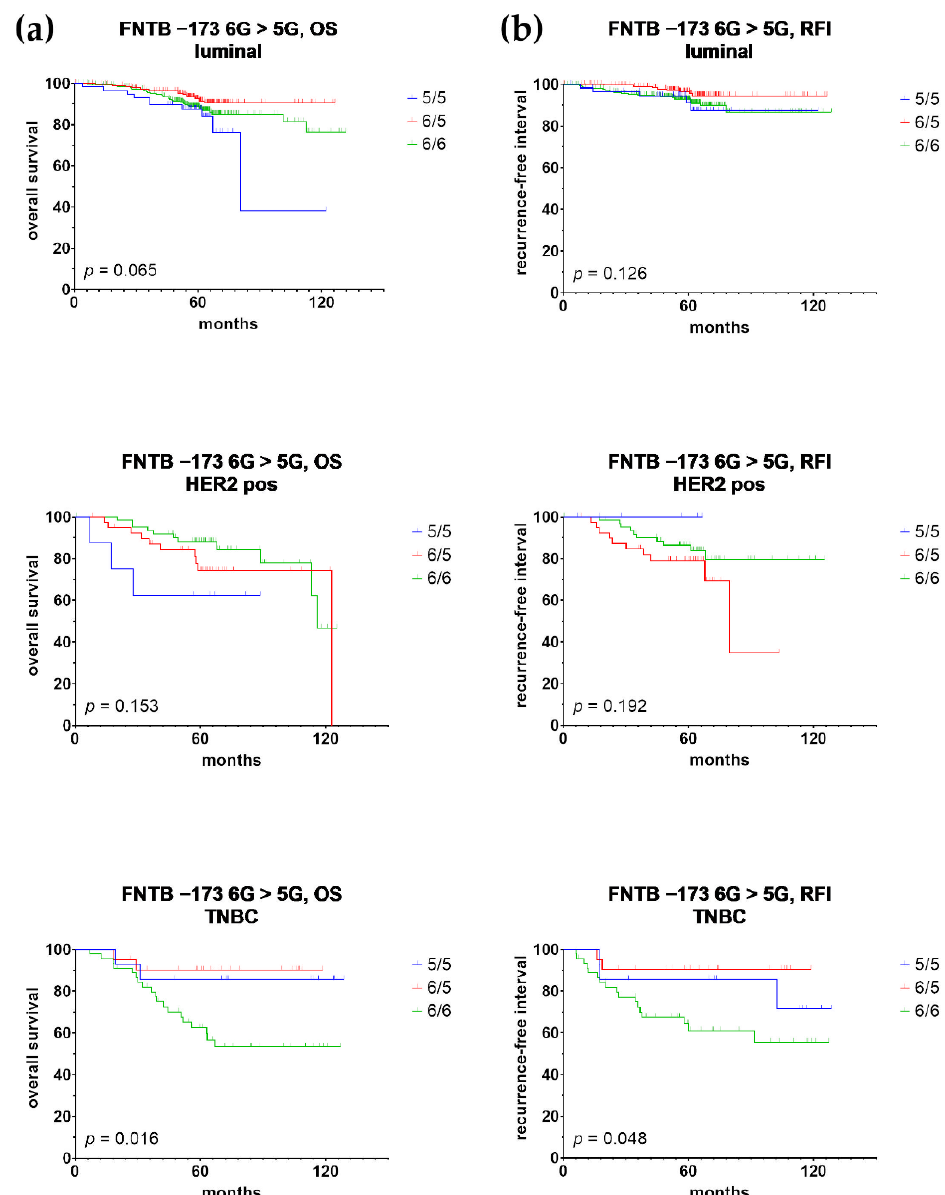
Figure 3. Kaplan–Meier analysis of overall survival (OS, ( a )) and recurrence-free interval (RFI, ( b )) in patients with luminal, HER2-positive and triple-negative breast cancer, stratified by promoter polymorphism rs3215788 (FNTB-173 6G > 5G) genotypes.